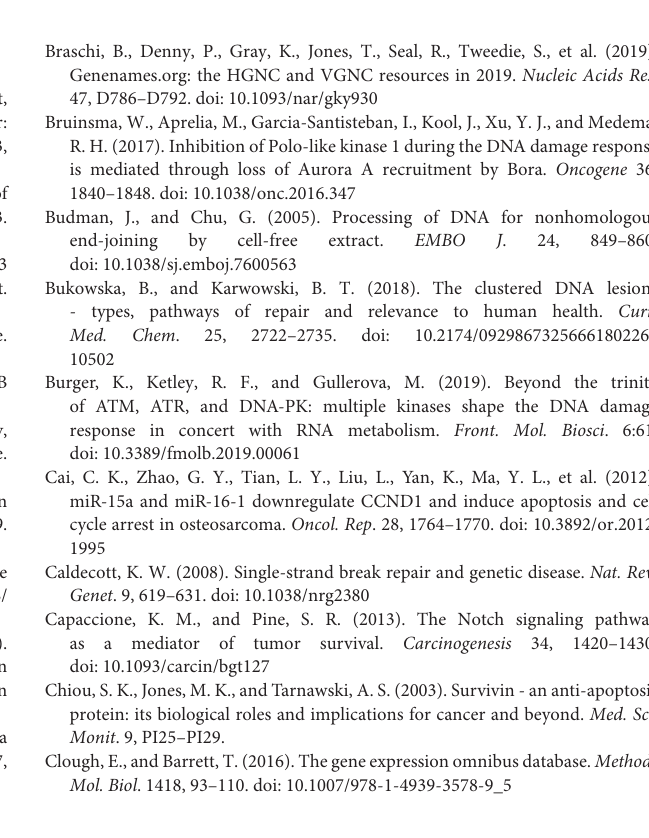
Supplementary Table 3 | List of the merged DEGs from each dataset, literature-derived genes/proteins and common